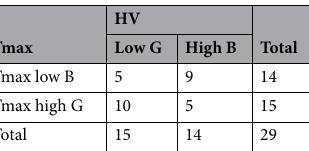
Table 4. Distribution of 33 patients by dichotomized Tmax and